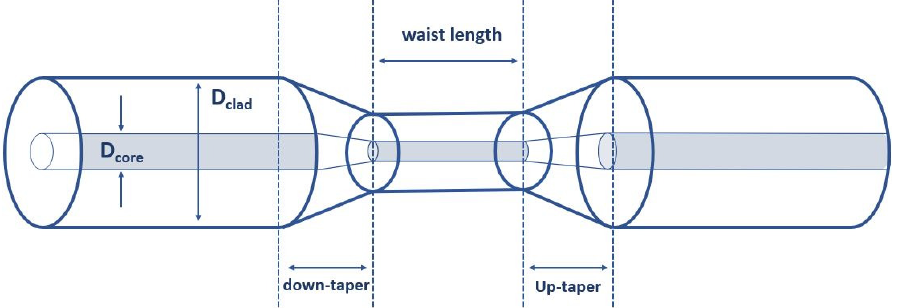
Figure 2. A sketched figure of tapered fiber profile with a uniform waist.